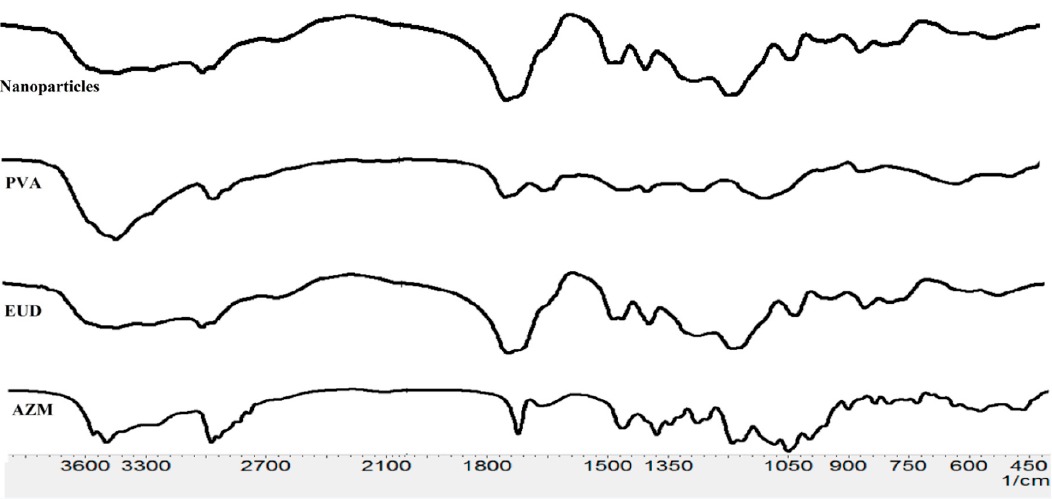
Figure 3. Fourier-transform infrared (FTIR) spectra of AZM, Eudragit ® L100, PVA, and AZM- Eudragit ® (EUD) nanoparticles (NPs).